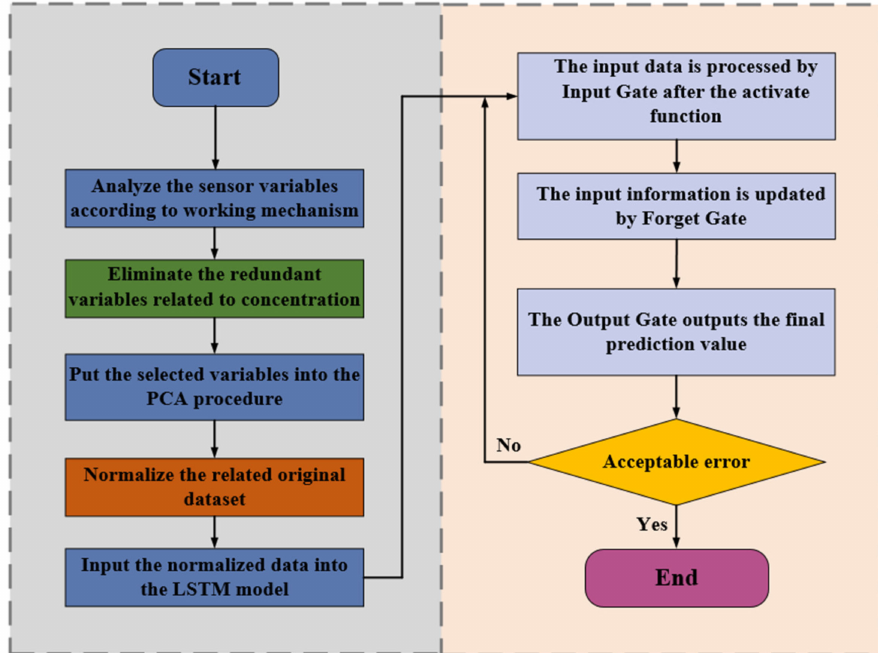
Figure 2. The flowchart of proposed novel PCA-LSTM based on mechanism.